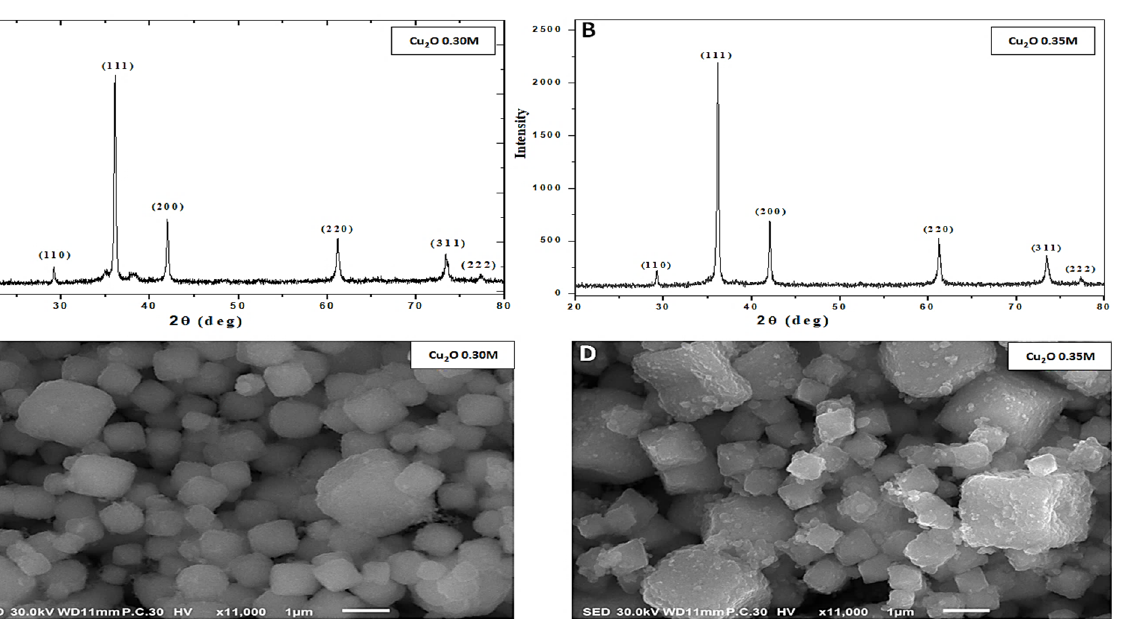
Figure 2. Average grain size distribution of 0.30 and 0.35 of Cu 2 O NPs ( A ) and room temperature PL spectra of fabricated Cu 2 ONPs ( B , C ). 3.2. Antifungal Activity of Cu 2 ONPs Against F. solani under Laboratory Conditions The effects of Cu 2 ONPs with its two molar concentrations, Cu 2 ONPs (0.35) and Cu 2 ONPs (0.30), on the mycelial growth of F. solani compared to the fungicide are pre- sented in Table 2 and Figure 3. The results showed that the used Cu 2 ONPs and the fungi- cide significantly inhibited the growth of F. solani compared to the untreated control . The most effective treatment was the fungicide, followed by Cu 2 ONPs (0.30 M) and Cu 2 ONPs (0.35 M), respectively. In addition, there was a strong correlation between the inhibition percentage of the tested treatments and their concentrations.